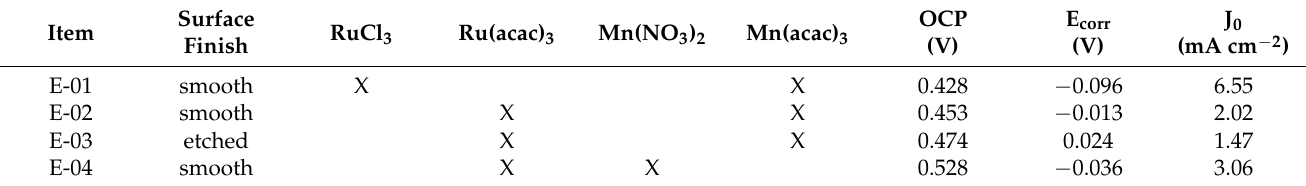
Table 1. Electrode characteristics: composition and corrosion